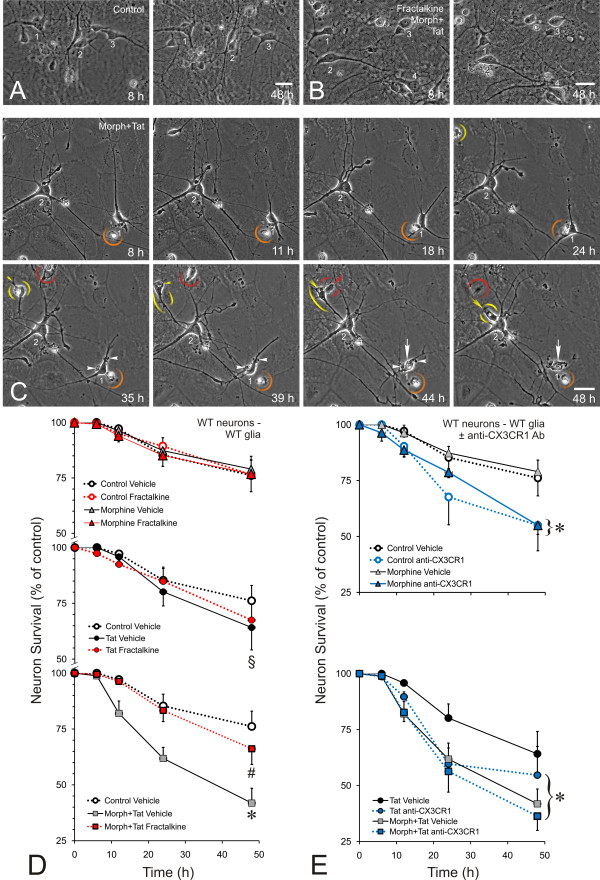
Effects of fractalkine on morphine and/or HIV-1 Tat-induced toxicity was repeatedly tracked in individual striatal neurons (A-E). A within-subjects design and computer-assisted, time-lapse tracking of individual neurons is used to compare the survival of the same neuron before and at 20 min intervals throughout treatments (A-E). Thriving neurons are evident in control (A; neurons 1-3) or morphine (Morph) + Tat-treated cultures co-administered fractalkine (B; neurons 1-4) at 48 h. By contrast, increased neurodegeneration and death was apparent with morphine plus Tat exposure (C). Neuron death is often preceded by the systematic degeneration of neurites and fragmentation of the cell body (Tat + morphine treatment; arrowheads, neuron 1), while death per se occurs precipitously; denoted here by fragmentation of the cell body and some loss of birefringence (arrow, neuron 1; 44 h and 48 h) (C). Some individual microglia that were tracked are encircled in red, orange, and yellow, respectively (arrowheads indicate prior movement); there was close association of microglia with the dying (1) and surviving (2) neuron (not all microglia in the fields are encircled) (C). Neuron death has been confirmed using other viability markers (see text). Many neurons remain viable despite morphine and Tat co-exposure (e.g., neuron 2); some surrounding cells, including astroglia, immature glial precursors and microglia, can display sporadic movement; scale bars = 20 μm. While Tat alone did not cause significant neurotoxicity relative to controls by 48 h [61,62]; there was a significant interaction when overall neuron losses were compared in Tat versus non-Tat vehicle-treated cultures (§P < 0.03; Tat × time vs. Vehicle-control × time). Compared to controls or exposure to fractalkine alone, combined morphine and Tat (Morph+Tat) treatment increased neuronal death at 48 h (D) (*P < 0.05 vs. controls). Exogenous fractalkine (1 μg/ml) (red markers and connecting lines) prevented the accelerated neuronal death caused by combined Morph+Tat (#P < 0.05 vs. Morph+Tat) (D). By contrast, CX3CR1 immunoblockade (blue markers and connecting lines) by itself caused significant neurotoxicity that was indistinguishable from the combined effects of Morph+Tat (E) (*P < 0.05 vs. controls). Moreover, when CX3CR1 blockade was combined with Morph+Tat, there were no additive neuron losses (E). The findings suggest a critical role for fractalkine-CX3CR1 signalling in potentiating the toxic effects of opioids in Tat-exposed neurons; data are the mean number of surviving neurons (compared to pretreatment numbers) ± SEM from n = 3-6 experiments; wild-type (WT) neurons and mixed glia; antibodies (Ab); scale bar = 20 μm.